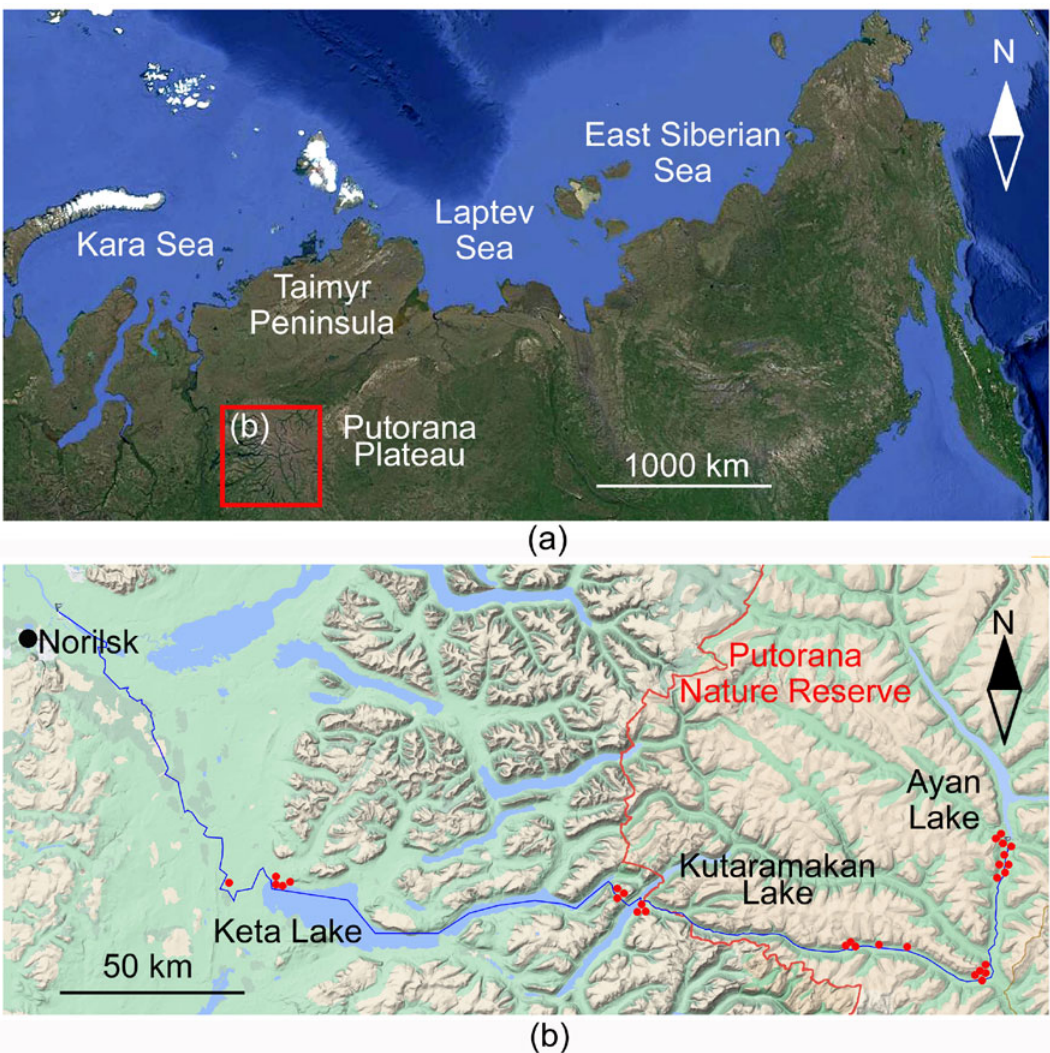
Figure 1. Map of Middle and Eastern Siberia ( a ) with position of the Putorana Plateau (red square); Putorana Plateau ( b ) with location of sampling stations (red points), border of Putorana Nature Reserve (red line) and expedition track (blue line).